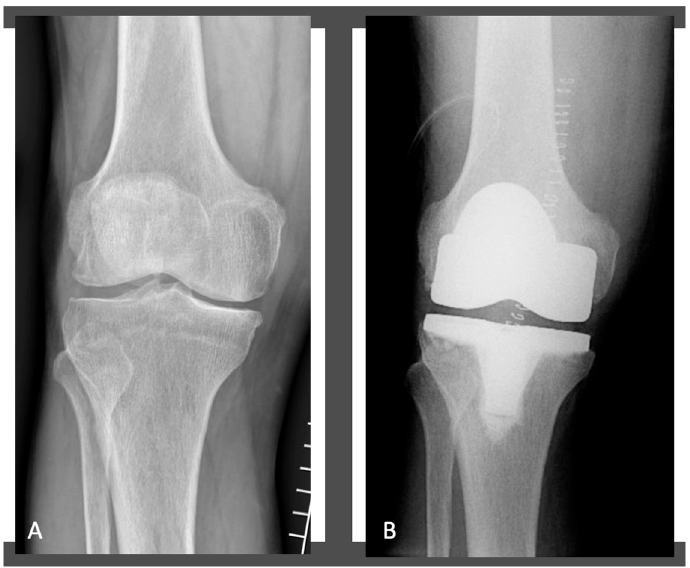
Figure 3. Radiographs of the patient’s knee before ( A ) and after KA MP-TKA ( B ).